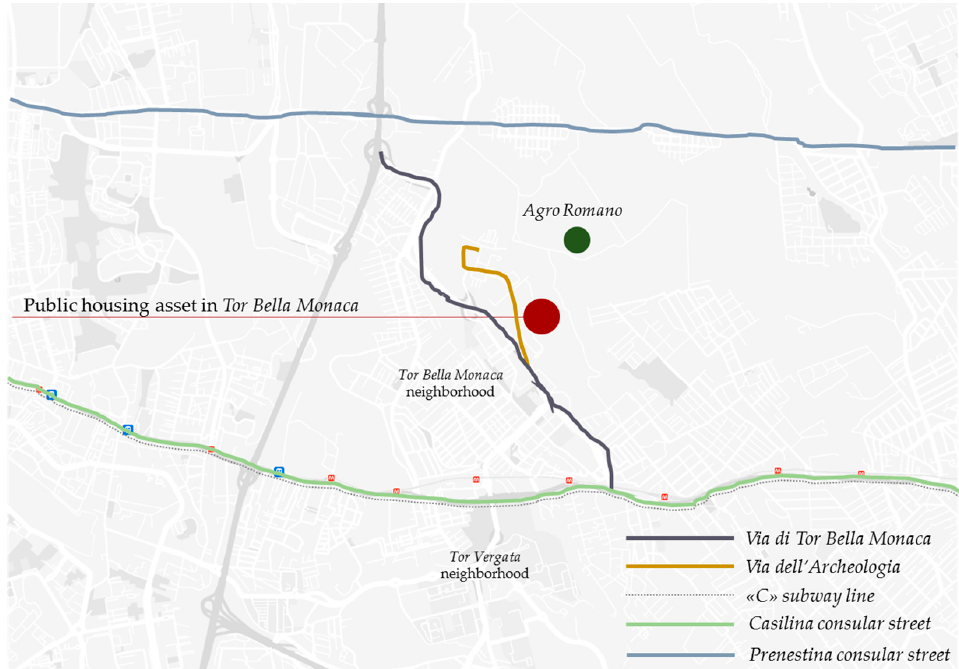
Figure 6. Tor Bella Monaca neighborhood and main road axes.